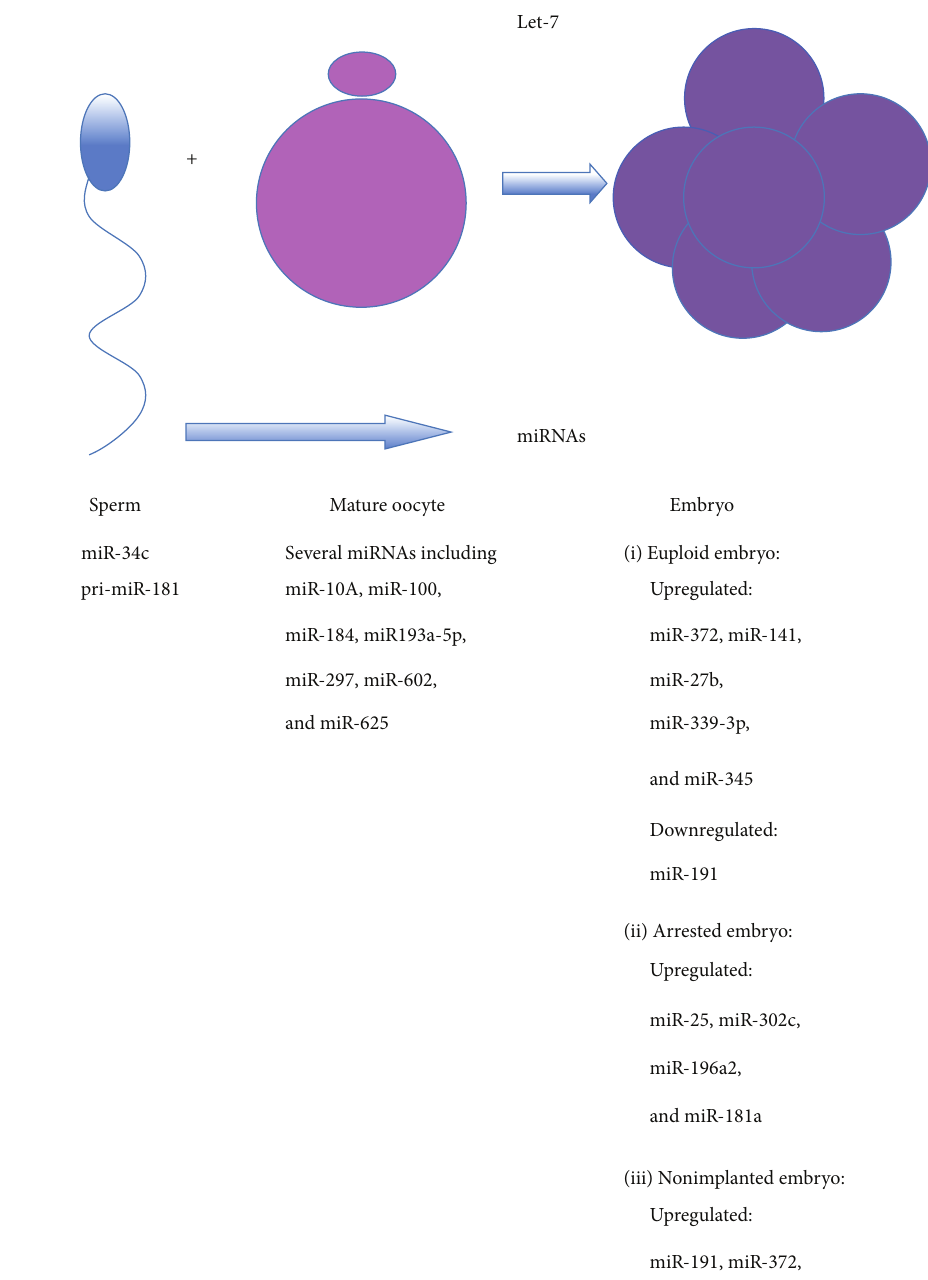
Figure 4: MiRNAs in human sperm, mature oocytes, and embryos, important for fertilization and embryo development [75–80]. Some miRNAs identified in sperm are contributed to the oocyte during the fertilization process and are involved in embryogenesis. Abundant maternal miRNAs of Let-7 family are involved in oocyte-to-embryo transition and are replaced by embryonic miRNAs, related to